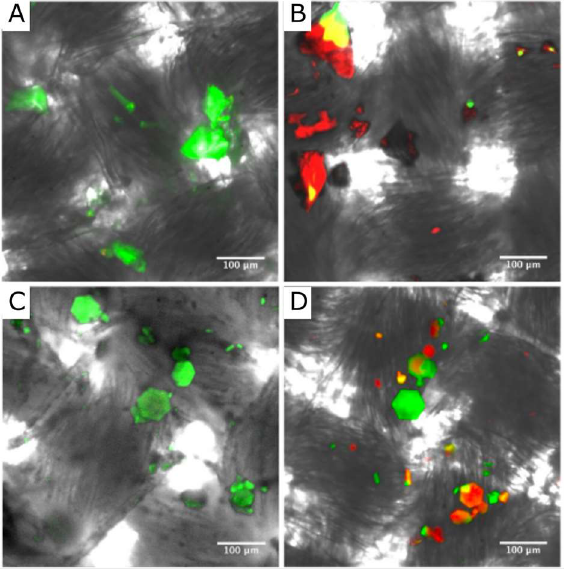
Figure 4. Composite confocal images of protein crystals conjugated to cotton fabric (DIC, 488 nm and 561 nm). ( A ) Location with empty fluorescein-labeled HEWL crystals (green). ( B ) After 24 h incubation with sulforhodamine 101, we imaged a new location showing HEWL crystals (dark gray), some with residual fluorescein signal (green), many showing sulforhodamine 101 uptake (red). ( C ) Location with empty fluorescein-labeled CJ-LPCs (green). ( D ) After 36 min incubation with sulforhodamine-labeled P450 (red), we imaged a new location showing CJ-LPCs with variable fluorescein (green) and guest enzyme (red) content. Unmerged DIC, green, and red channels are provided in Supplementary Figures S5 and S6.